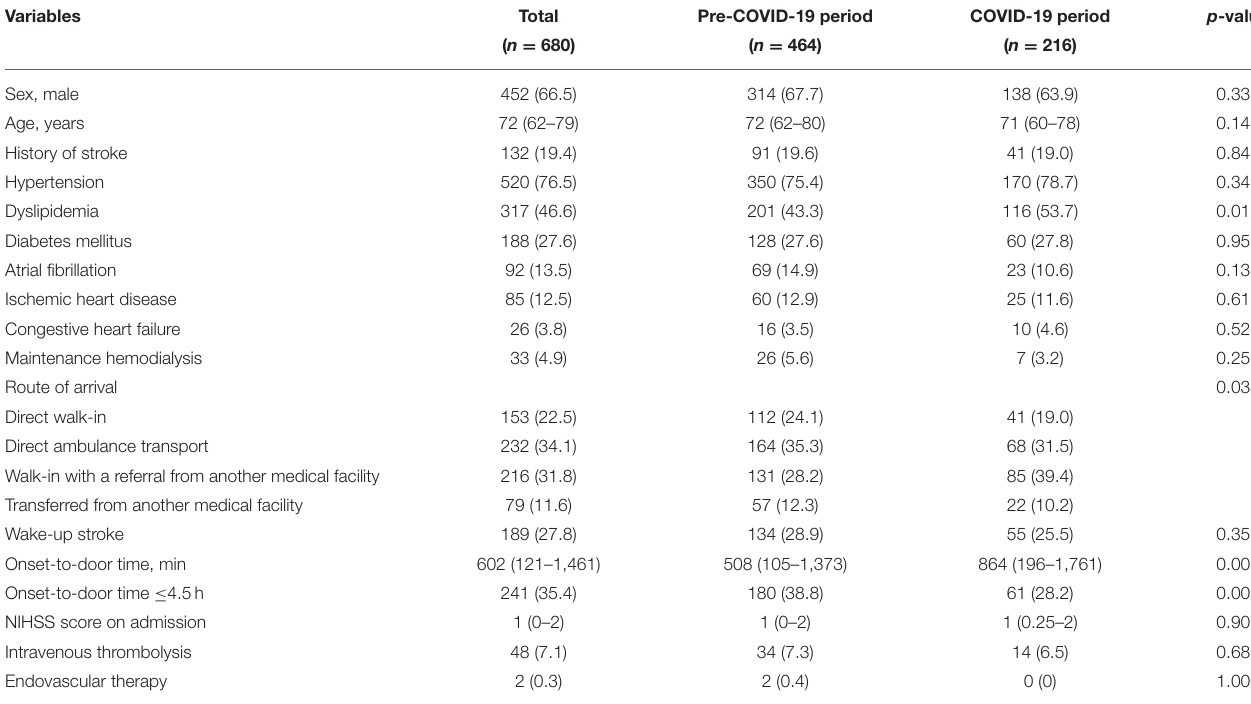
TABLE 1 | Characteristics of patients with transient ischemic attack/mild stroke.